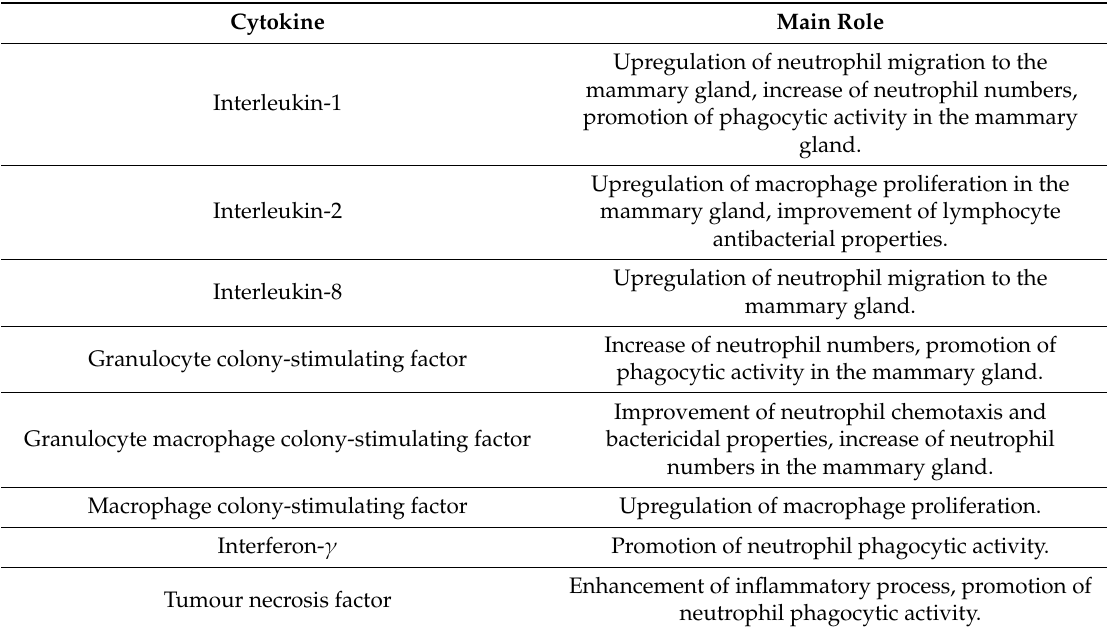
Table 2. Cytokines involved in mammary defence